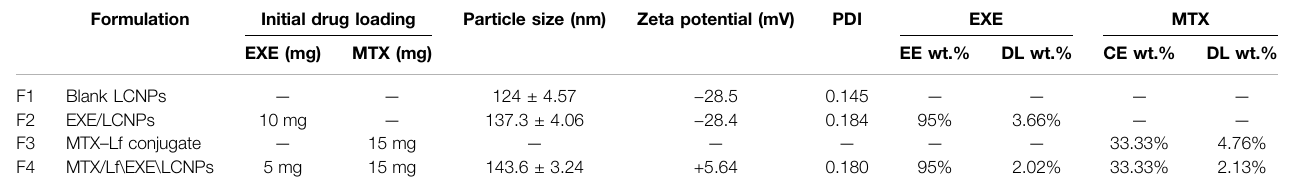
TABLE 1 | Physicochemical characterization, particlesize, zeta potential, encapsulation ef fi ciency (EE), conjugation ef fi ciency (CE), and drug loading (DL) of blank and drug- loaded LCNPs ( n = 3).